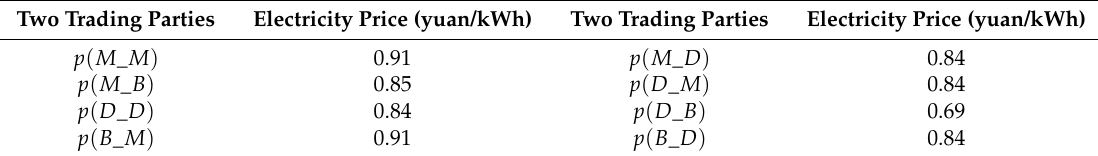
Table 2. Near global optimum bidding strategy at 12:00 p.m.